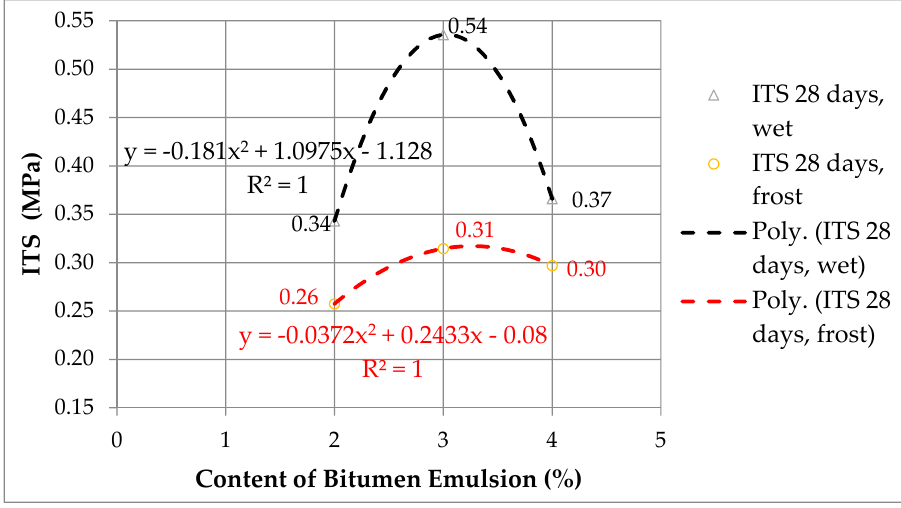
Figure 4. Dependence of indirect tensile strength (ITS) on emulsion content, wet specimens, and specimens exposed to frost.